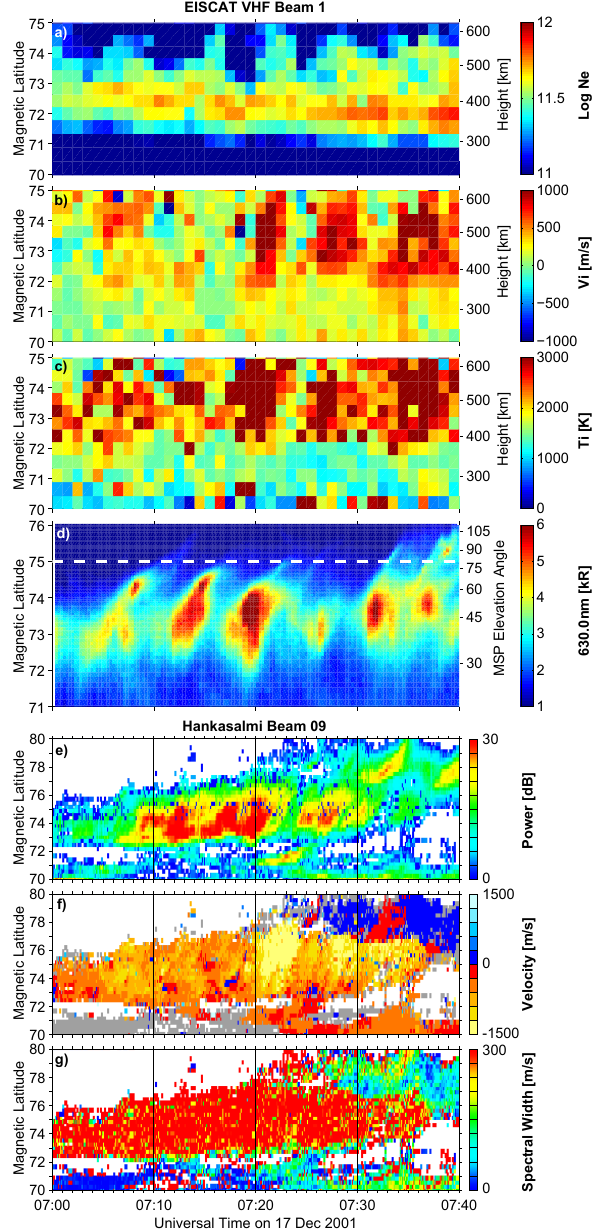
Fig. 4. Panels (a–c) show the parameters Log Ne, Vi and Ti from the EISCAT VHF radar looking over Svalbard for the same time range as in Fig. 2. Panel (d) shows 630.0nm emissions from a meridian scanning photometer at Ny- ˚Alesund. Panels (e–g) show backscat- ter power, Doppler velocity and spectral width measurements from beam 9 of the SuperDARN Hankasalmi radar in